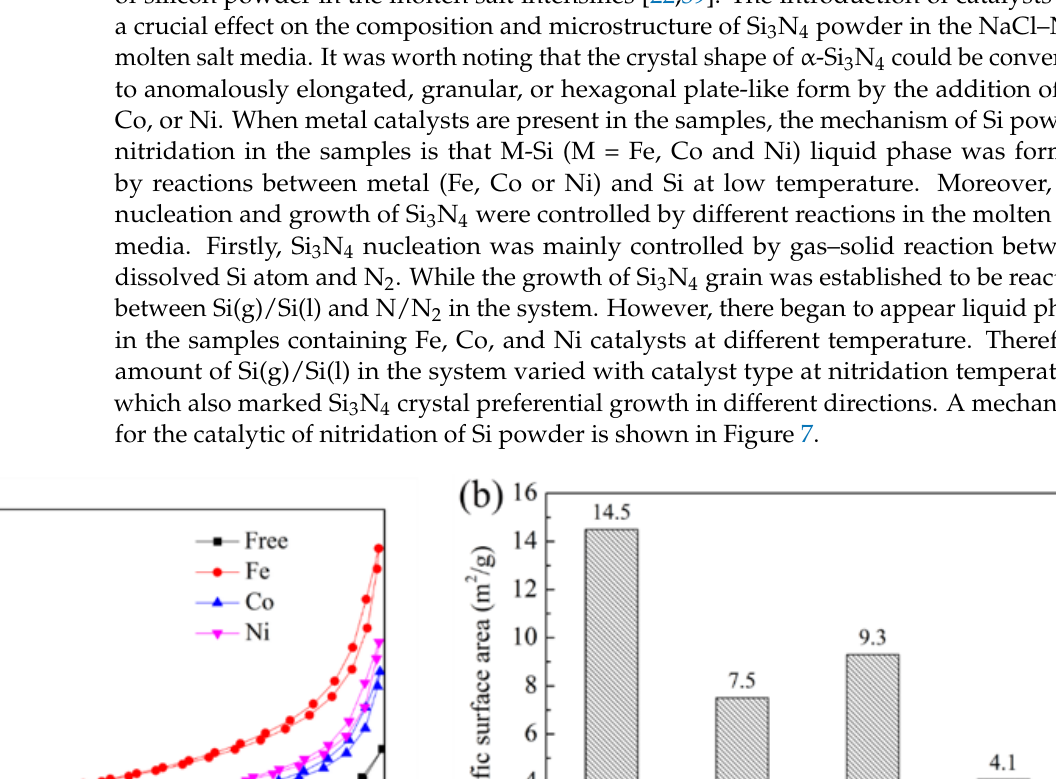
Figure 5. TEM images and SAED patterns (insets, area of A, B, and C) of samples containing ob- tained using catalysts. ( a ) 2 wt% Fe, ( b ) 2 wt% Co, ( c ) 2 wt% Ni, ( d ) an individual α -Si 3 N 4 hexagonal plate in the sample obtained using Ni as the catalyst.